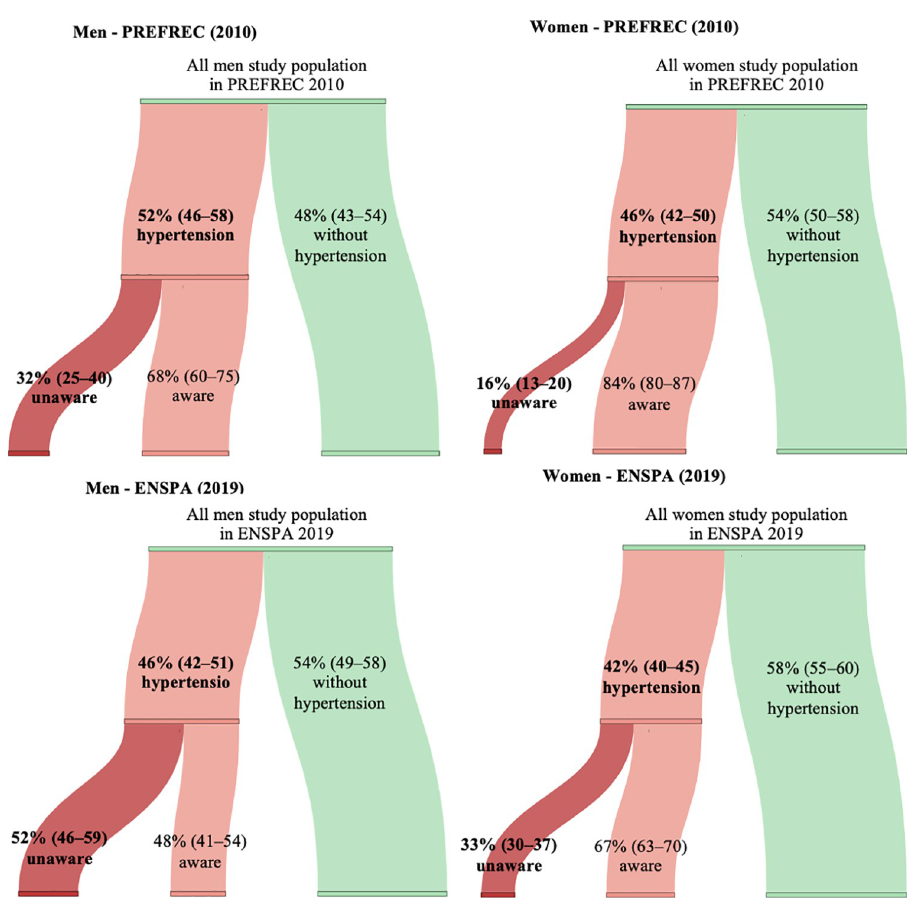
Fig 2. Prevalence and unawareness of hypertension stratified by sex and the study year. BP = blood pressure. The PREFREC (2010) study: men (n = 834 [N = 255 481]), women (n = 1 899 [N = 531 326]). The ENSPA (2019) study: men (n = 1 317 [N = 666 751]), women (n = 3 334 [N = 677 584]).